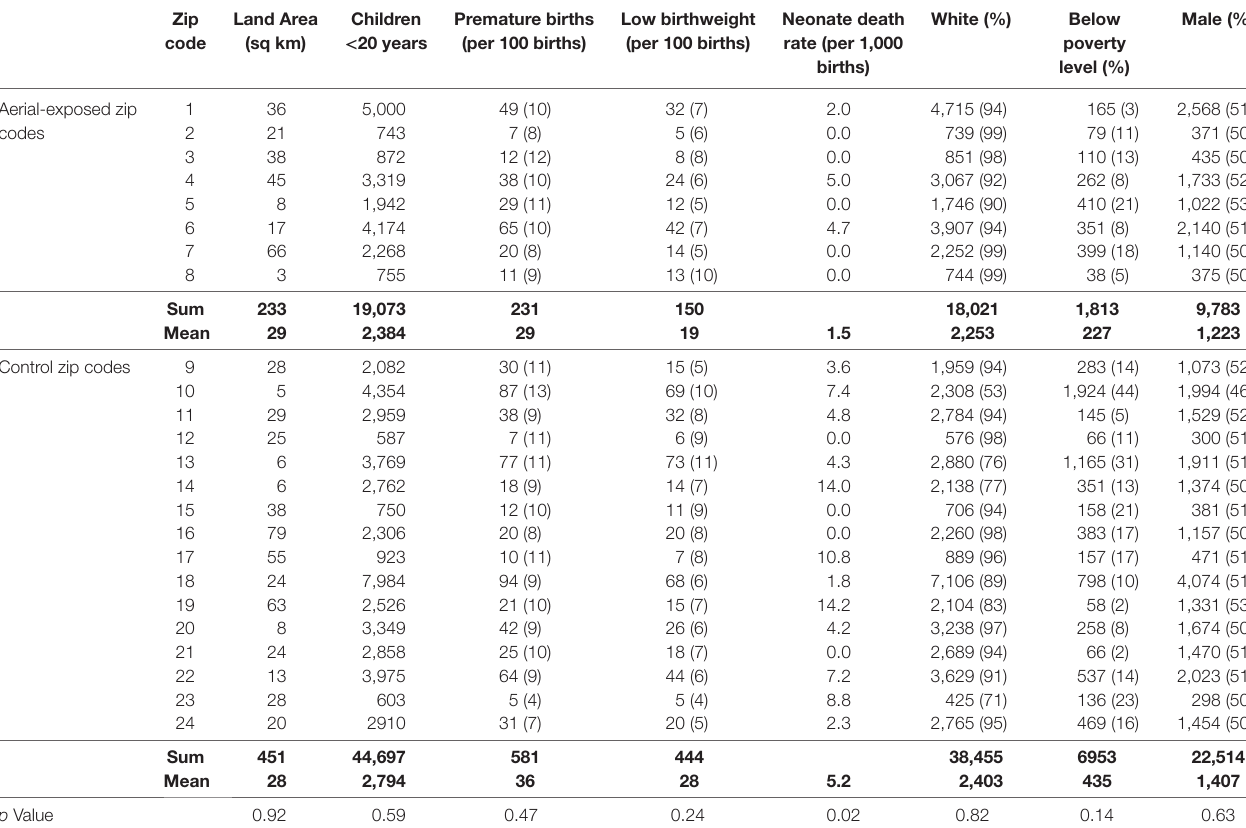
TaBle 1 | Demographic data from 8 zip codes exposed to aerial pyrethroid pesticides and 16 control zip codes. Zip